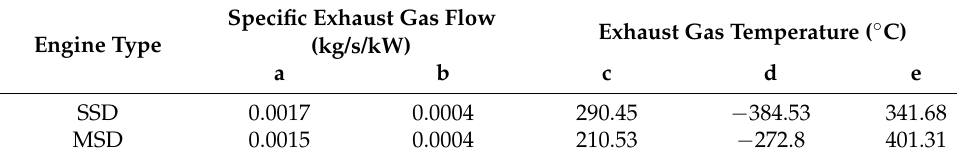
Table 1. Summary of coefficients for engine exhaust gas correlations.